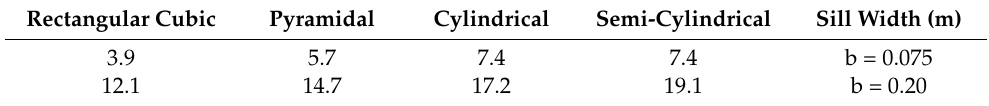
Table 2. Increase in sill gate discharge coefficients compared to non-sill gates (%).